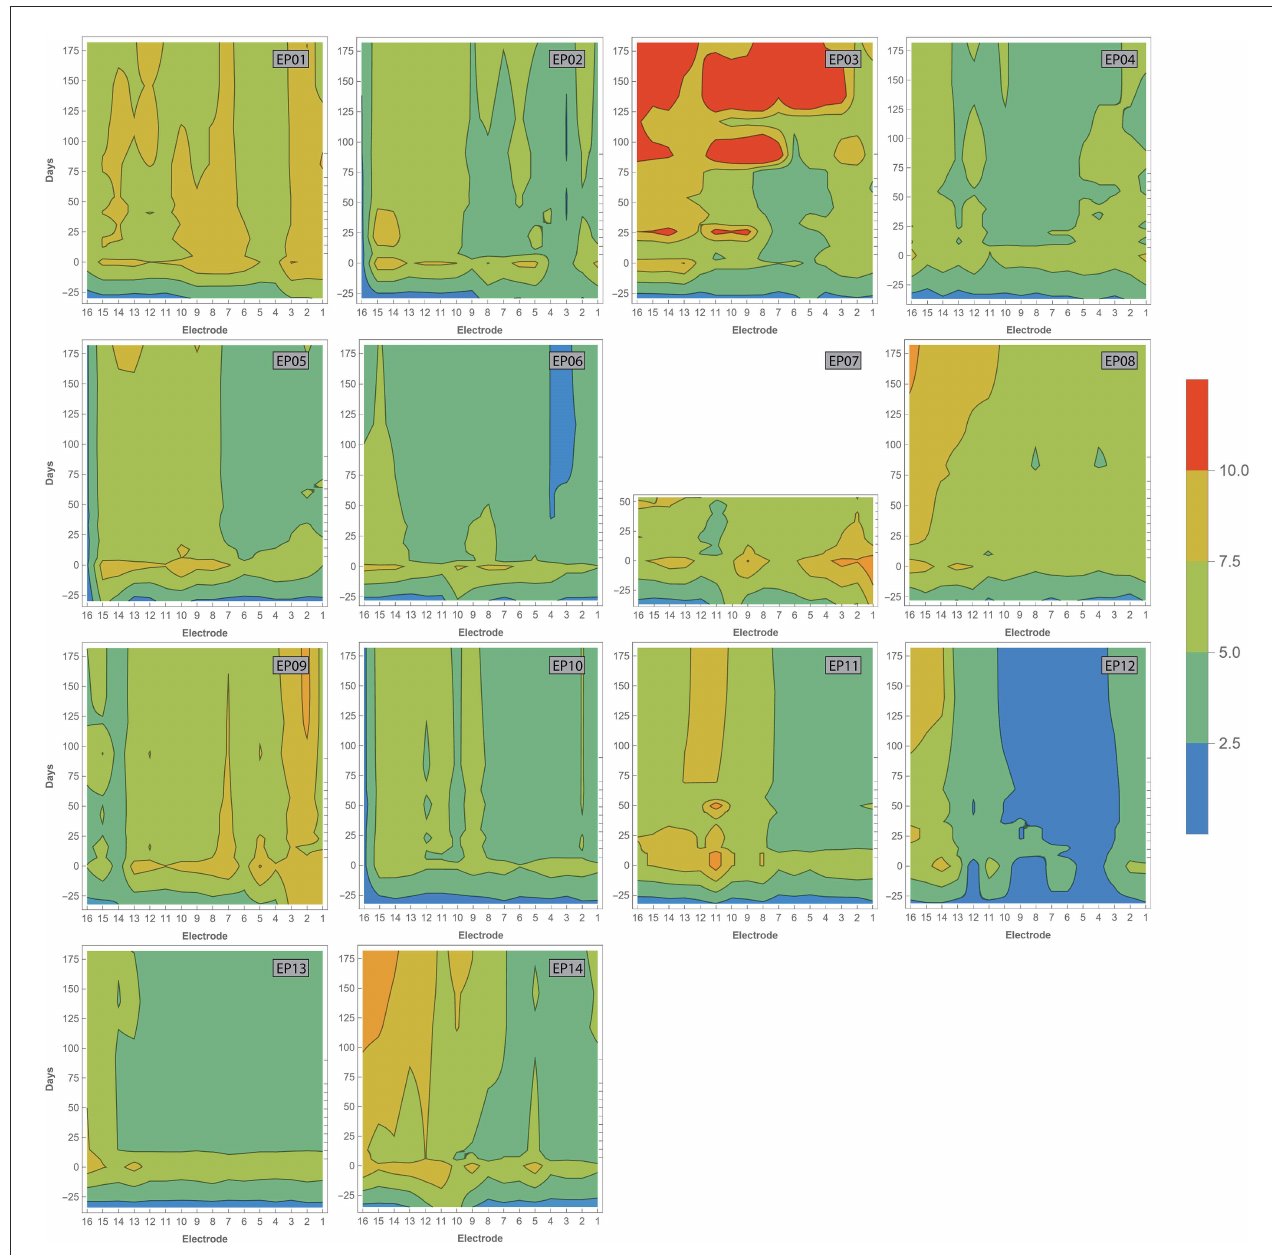
FIGURE7 Contour plots showing varying impedances with time (in days, vertical axis) across the electrode array (horizontal axis). Measurements have been performed during surgery, and at every fitting session during the first 6 months of CI rehabilitation. Day 0 represents the first fitting. Colors indicate impedance values according to the legend. Open and short circuits are classified as impedances > 30 and 0.5–1.0 kOhm,